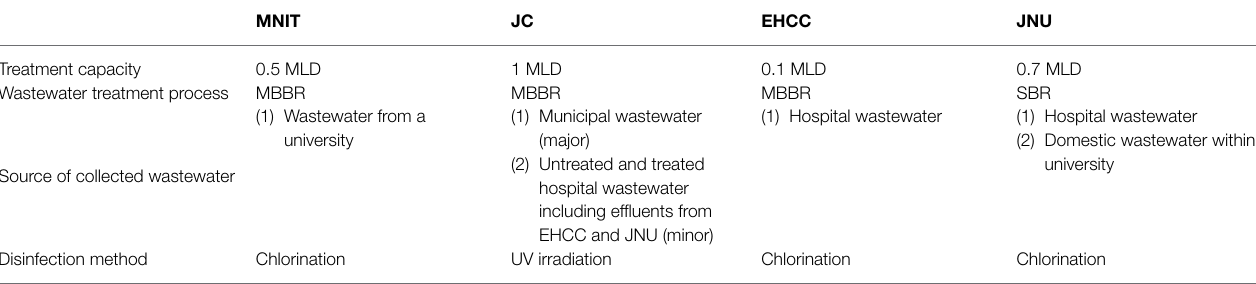
TABLE 1 | Characteristics of the four